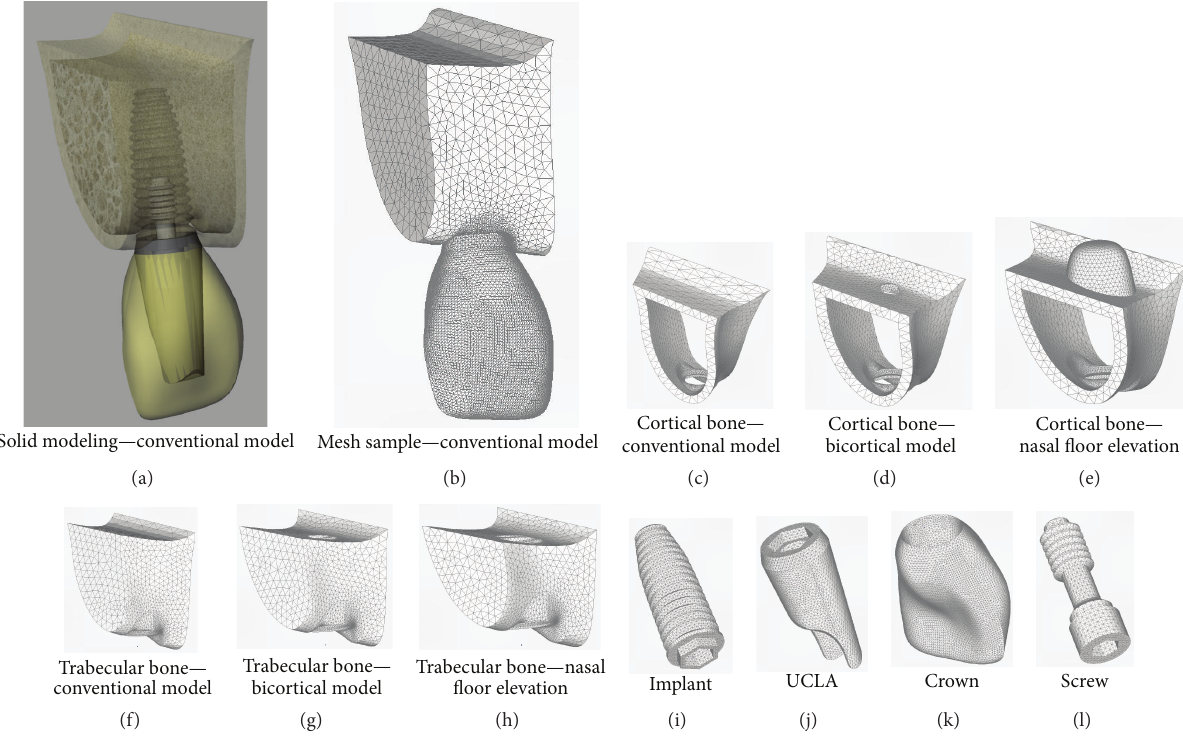
Figure 1: Solid modeling and generated mesh samples of all structures. (a) Modeling of model 1; (b) meshes of model 1; (c) mesh of cortical bone of model 1; (d) mesh of cortical bone of model 2; (e) mesh of cortical bone of model 3; (f) mesh of trabecular bone of model 1; (g) mesh of trabecular bone of model 2; (h) mesh of trabecular bone of model 3; (i) mesh of implant of all models; (j) mesh of UCLA of all models; (k) mesh of crown of all models; (l) mesh of screw of all